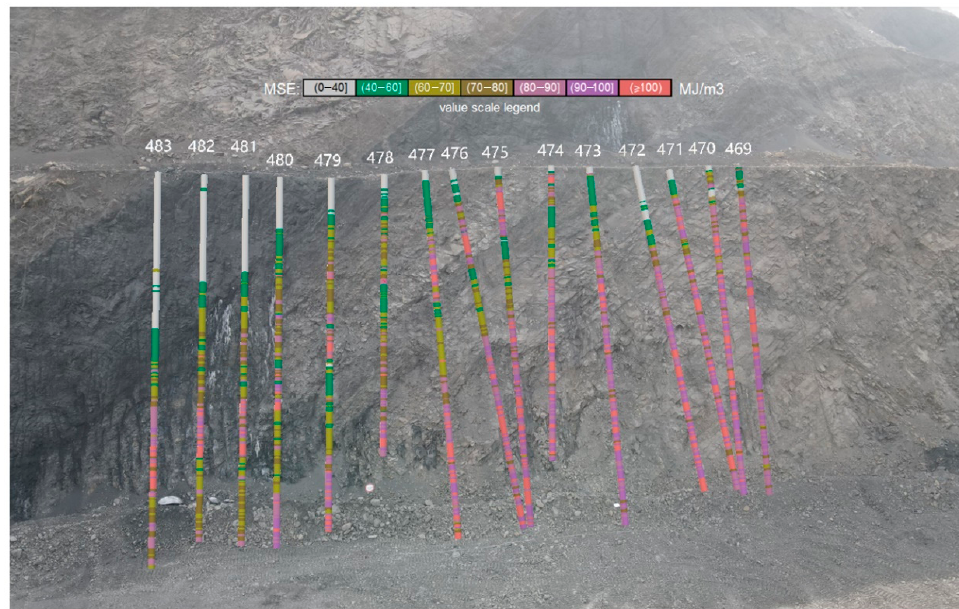
Figure 8. MSE distribution for blast holes in the pre-split row. Constructed borehole paths were based on the observed half-casts.